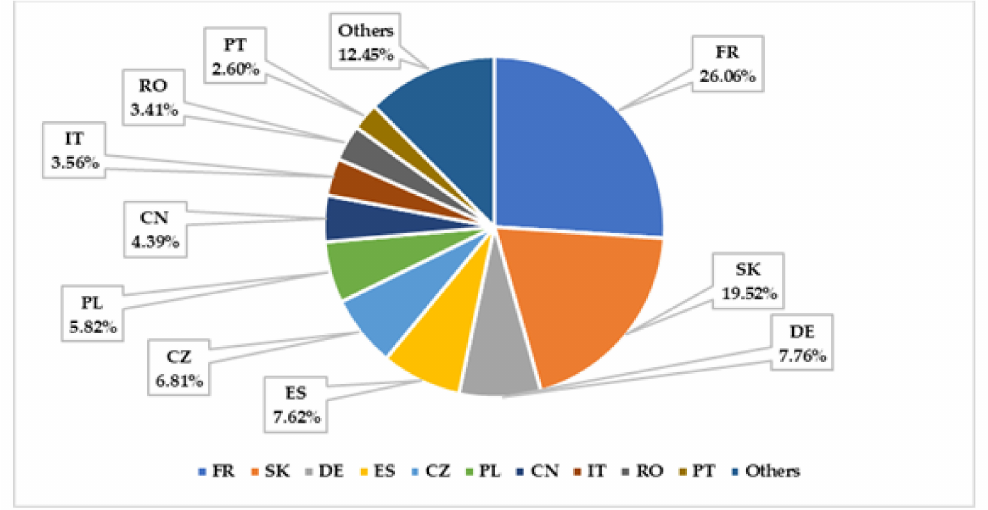
Figure 9. Value-added percentages (2021–2023) for C3 and 208 automobiles, broken down by nation after implementing Industry 4.0 trends. Source: Authors’